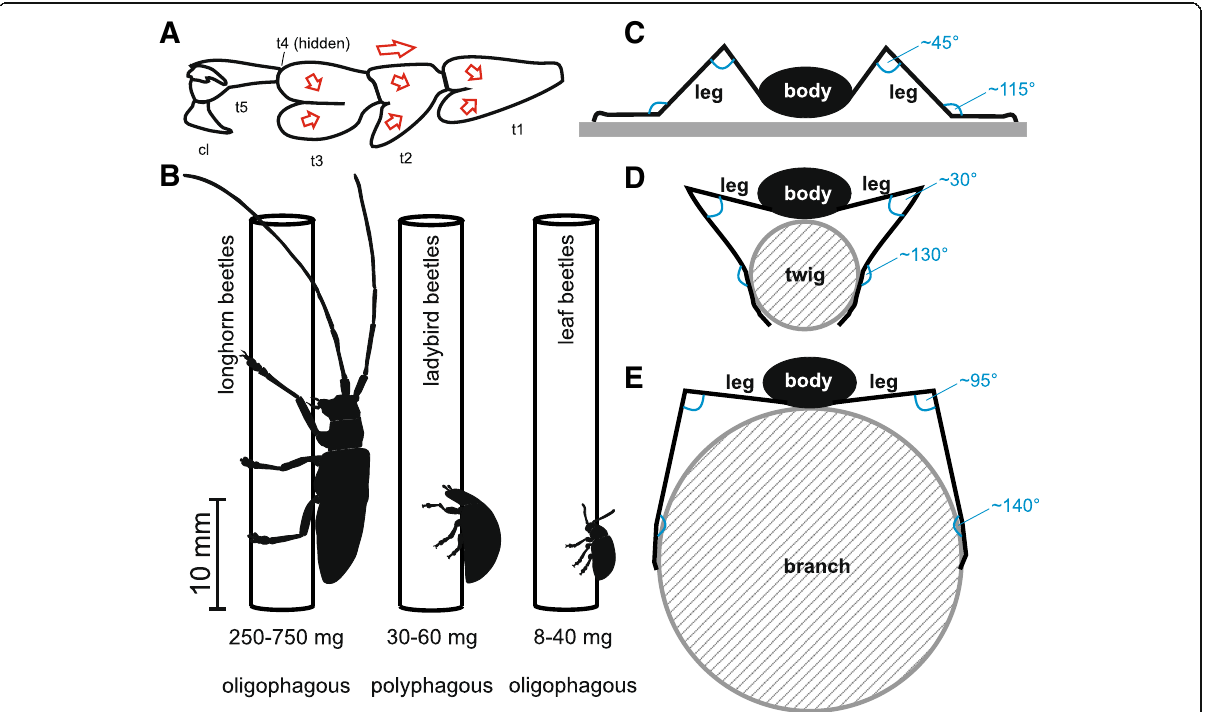
Fig. 5 Schematic drawings illustrating several aspects in longhorn beetle attachment. a . Directions of shearing ( arrows ) on the ventral tarsus, according to the alignment of adhesive setae (see Fig. 2 for comparison). t1 – t5, tarsomeres; cl, claw. b . Comparison of body dimension and posture between longhorn, ladybird, and leaf beetles grasping a rod-shaped substrate. c – e . The longhorn beetle body posture on a flat and a rod-shaped substrate having different diameter. Blue lines and letters indicate the angles between leg